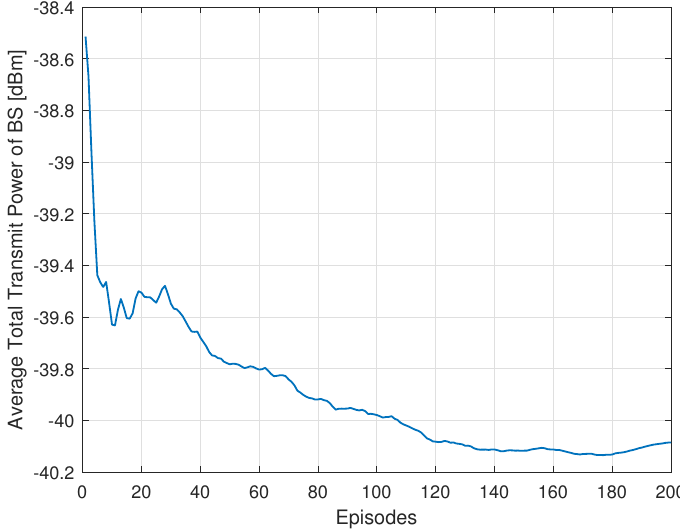
Figure 11. Average total transmit power of BS versus learning